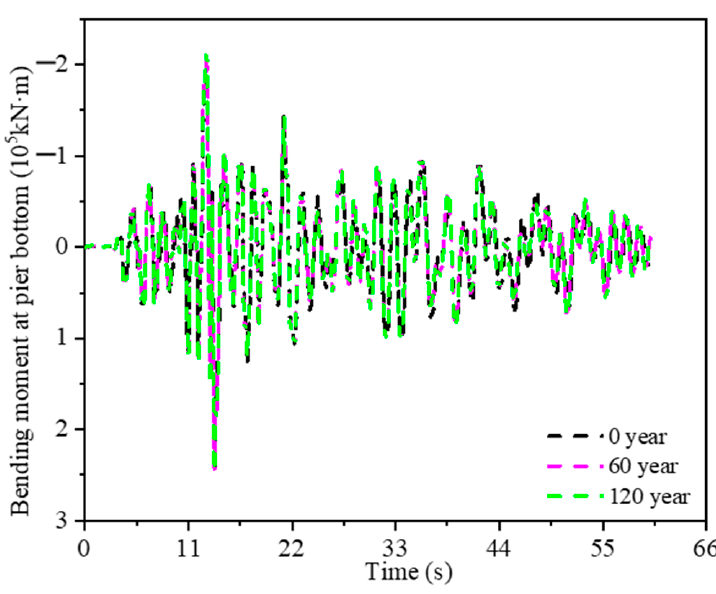
Figure 19. Time history curve of 2# pier bottom bending moment under LRB degradation.